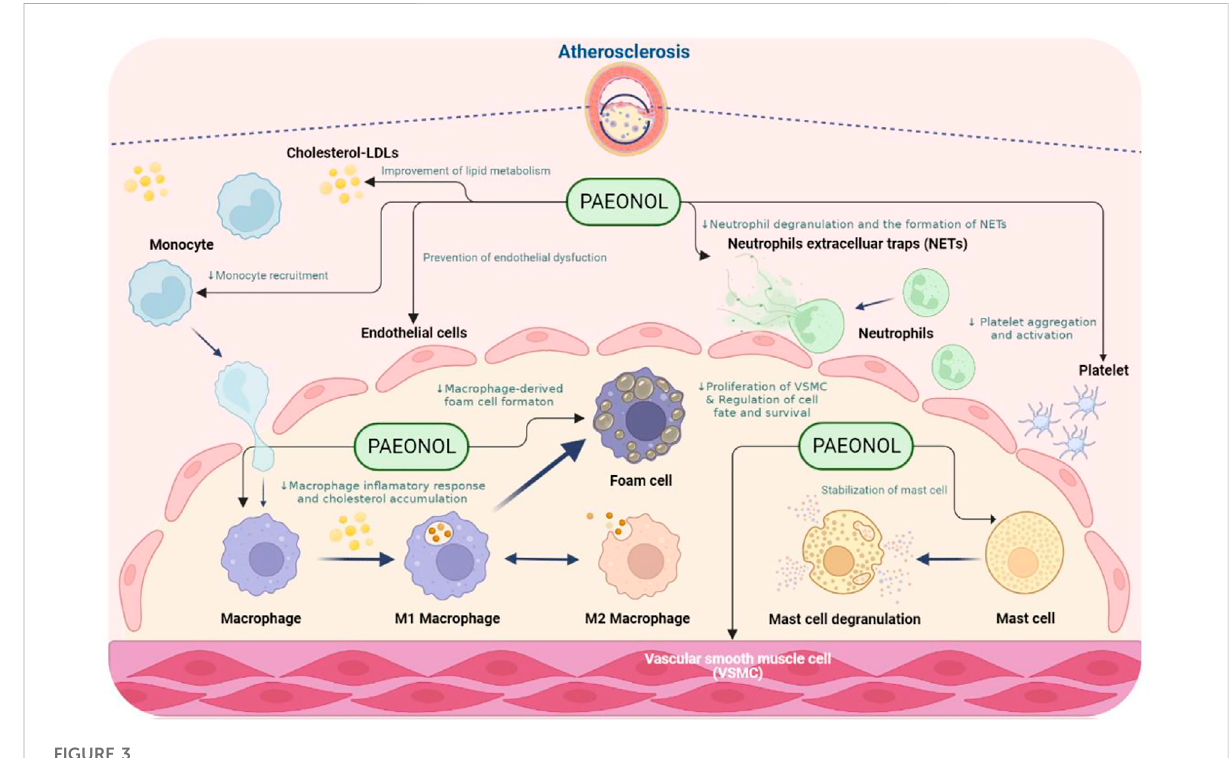
FIGURE 3 The anti-atherosclerotic effects of paeonol. NOTE: Created in